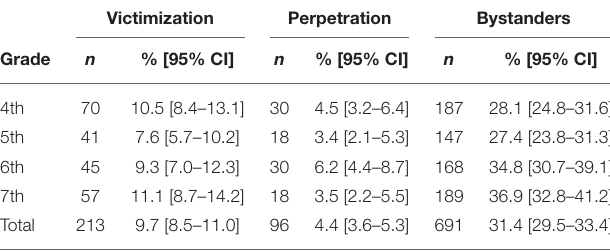
TABLE 6 | Cyberbullying by grade ( n = 2,198; Missing data = 242).